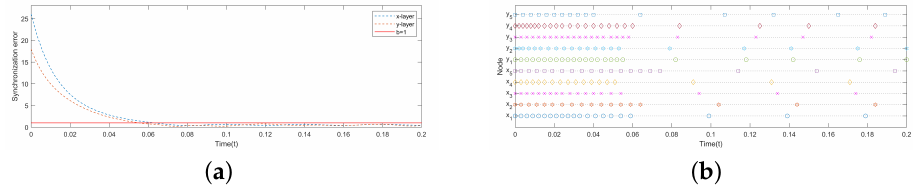
Figure 6. ( a ) ALS errors in the two − layered network. ( b ) Event − triggered instants on nodes x i and y i under condition (7).